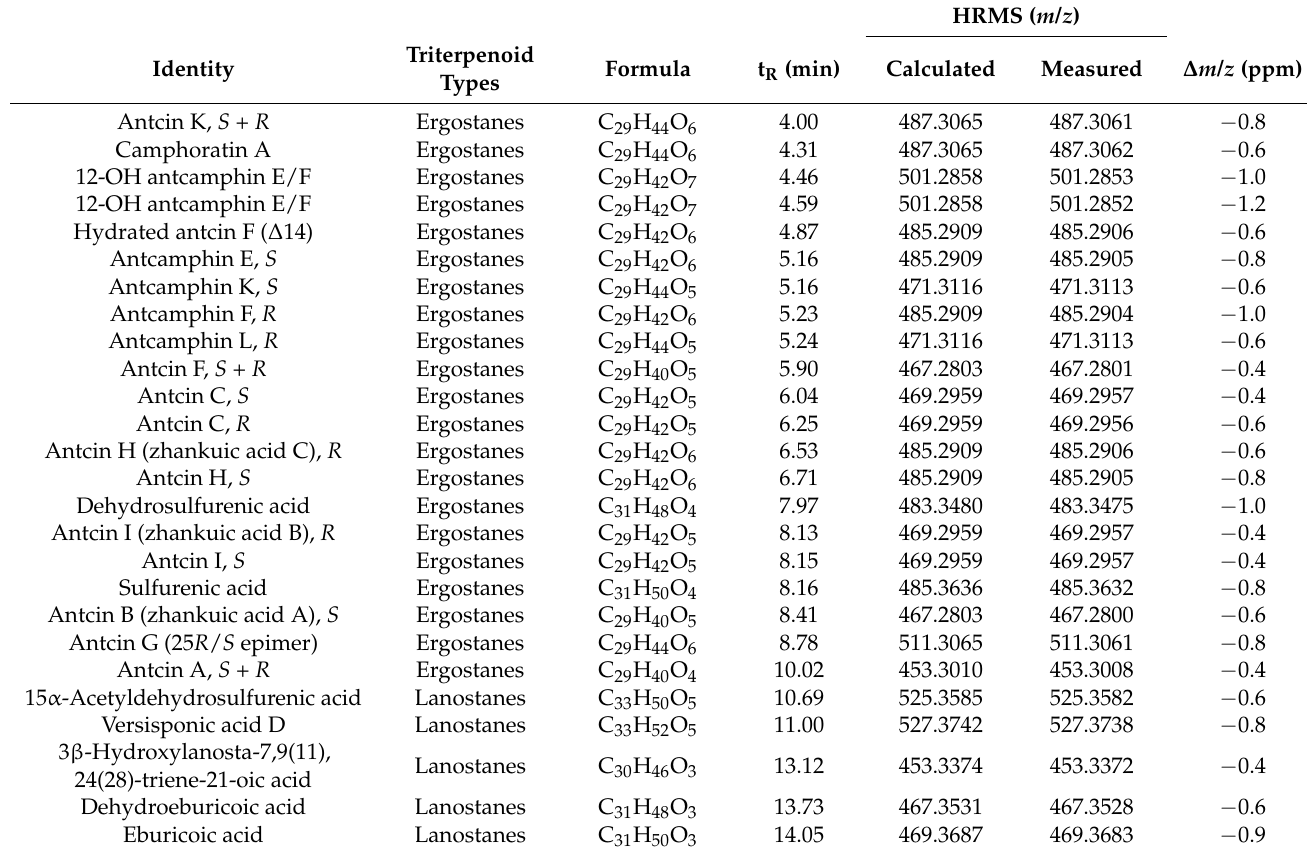
Table 1. Triterpenoid metabolites in different A. cinnamomea